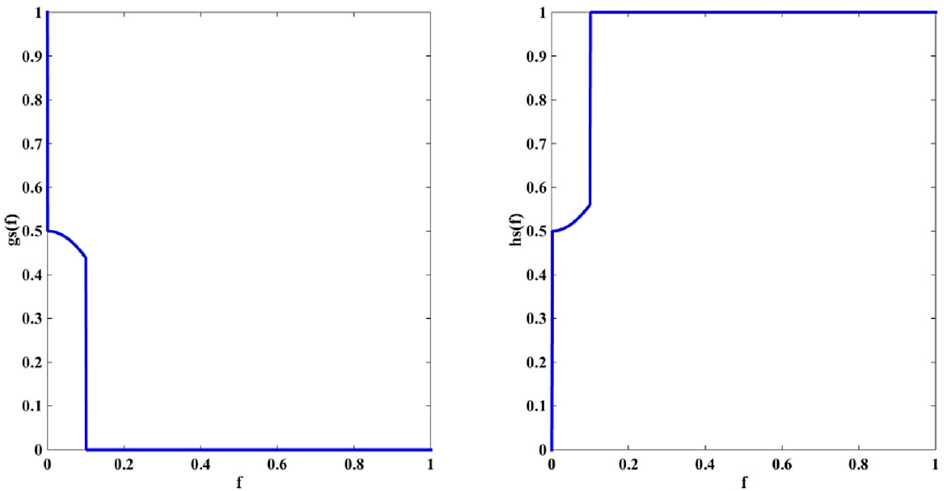
Figure 2. Variation of coefficients when (cid:2028) = 0.1.